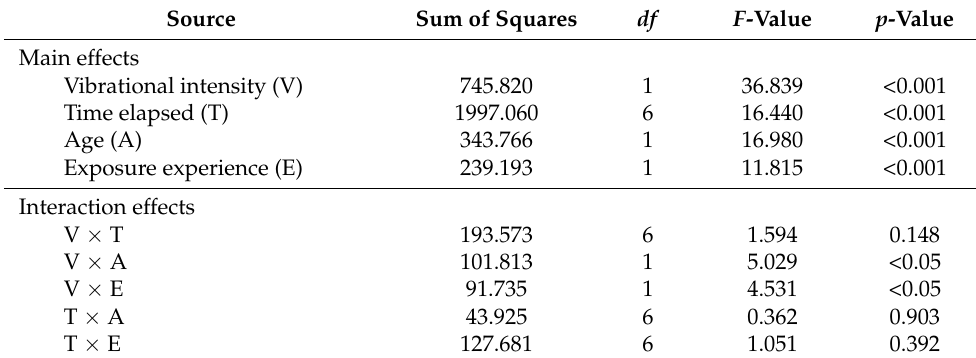
Figure 5. Temporary threshold shifts (TTSs) of vibrotactile perception at a test frequency of 125 Hz after exposure to high HAV ( a ) and low HAV ( b ). G1 denotes the exposed old group, G2 denotes the non-exposed old group, and G3 denotes the non-exposed young group. Table 4. ANOVA results of TTSs at a VPT test frequency of 125 Hz.